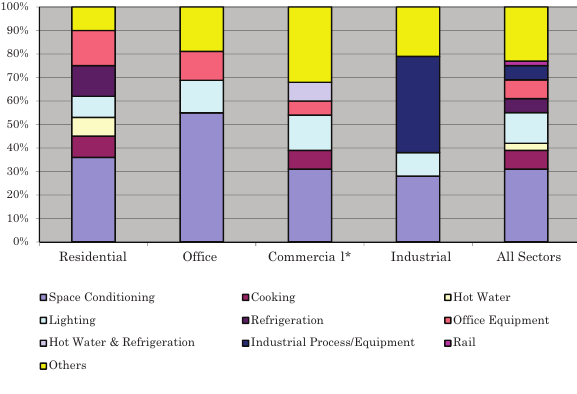
Fig. 3. Electricity End-uses by Sector in